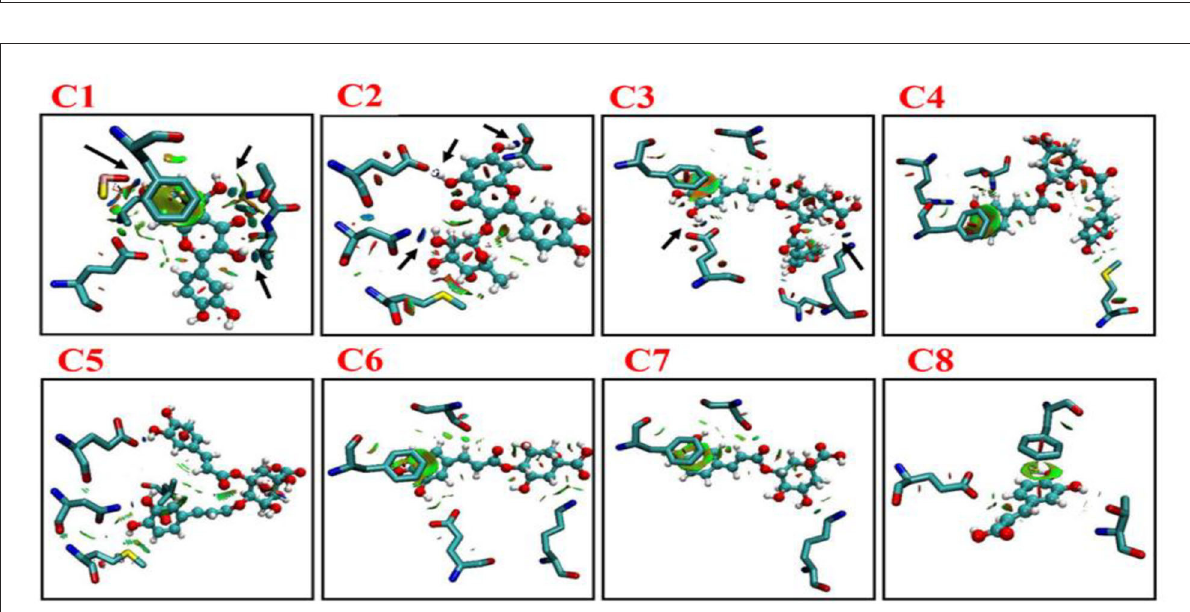
FIGURE9 Color mapped RDG isosurface graphs and scatter diagrams of different complexes phenolic compounds (C1 – C8). Blue represents strong attractive interactions, green represents vdW interactions, and red indicates strong steric effects. C1, quercetin; C2, quercetin-3-rhamnoside; C3, 4,5-O-dicaffeoylquinic acid; C4, 3,5-O-dicaffeoylquinic acid; C5, 3,4-O-di-caffeoylquinic acid; C6, 4-O-caffeoylquinic acid; C7, 3-O-caffeoylquinic acid; and C8, caffeic